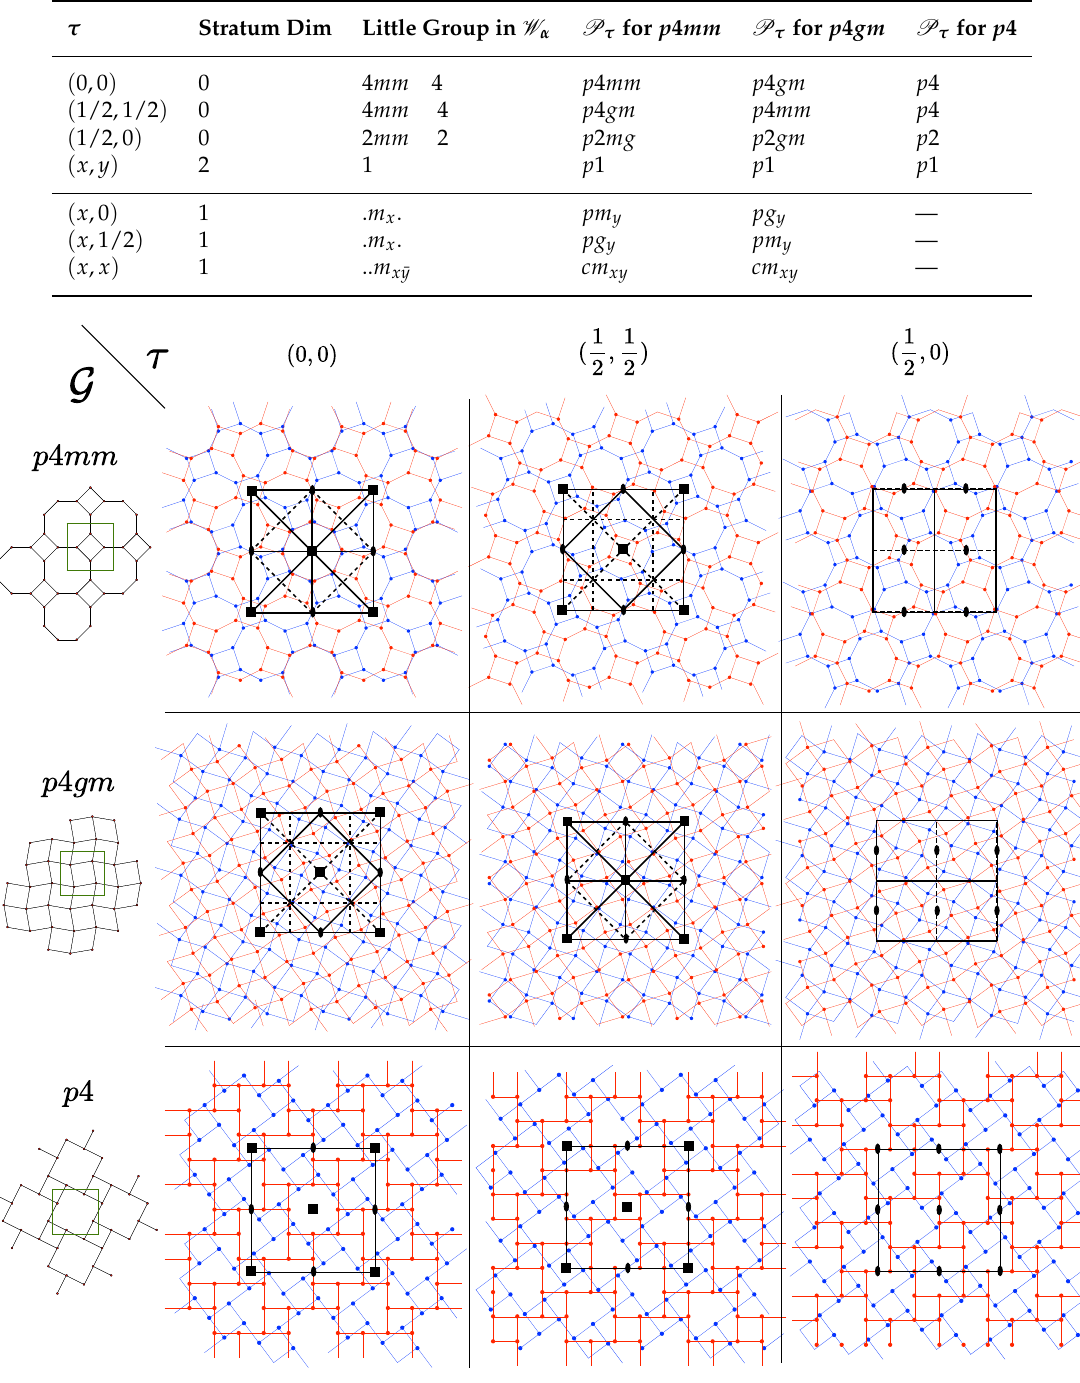
Figure 4. The possible space groups P τ given in Table 1 for the bicrystal generated by the rotation α = 2arctan ( m / n ) (here for n = 2, m = 1, Σ = 5, α = 53.1301 ◦ ) as a function of the rigid-body translation τ at the special points ( 0,0 ) , ( 1/2,1/2 ) and ( 1/2,0 ) for the three square symmetry space groups p 4 mm , p 4 gm and p 4. This scheme holds for any integer values of n and m